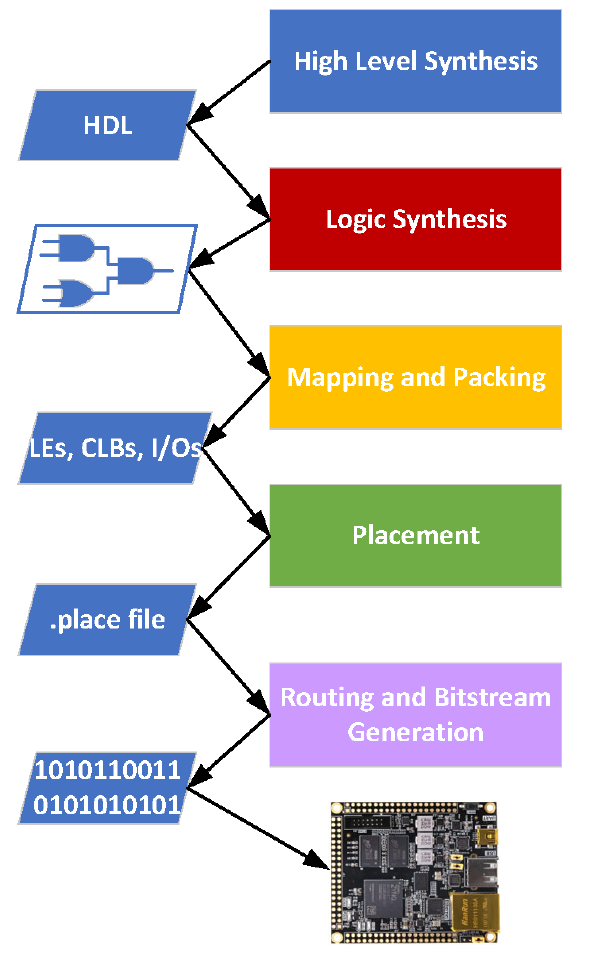
Figure 2. An overview of the conventional FPGA backend